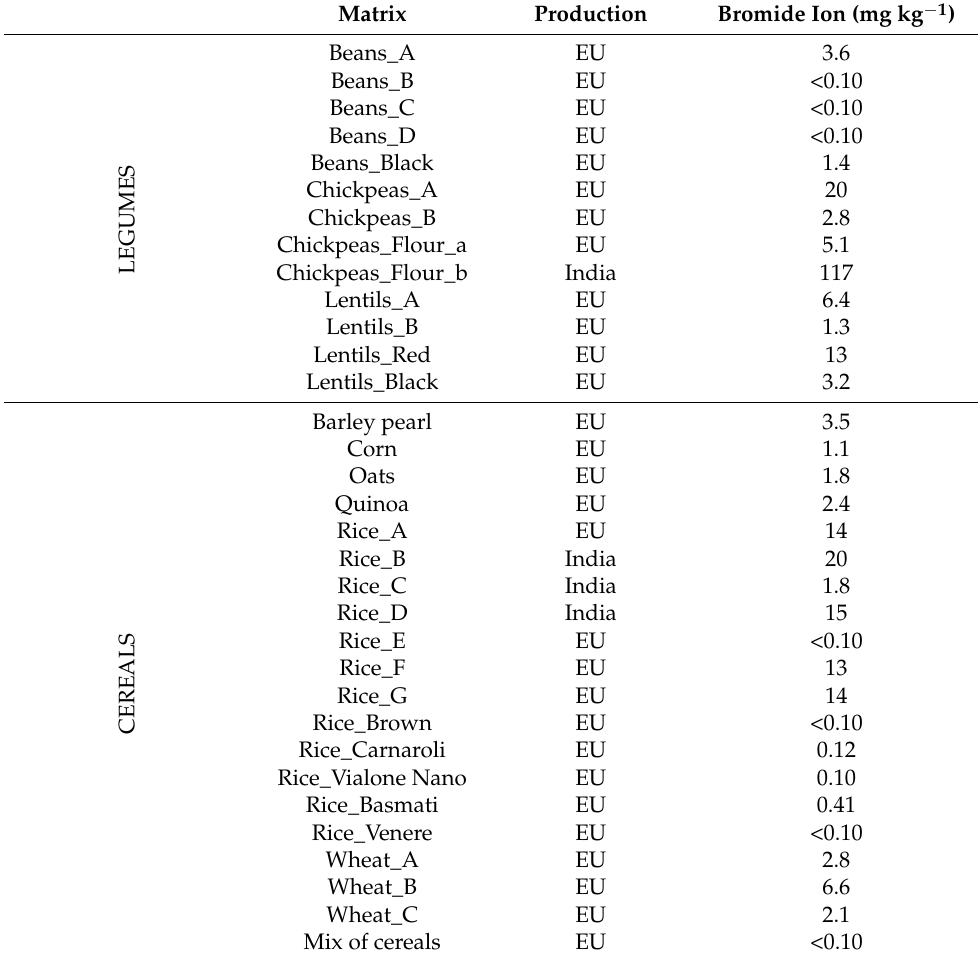
Table 1. List of samples analyzed for bromide